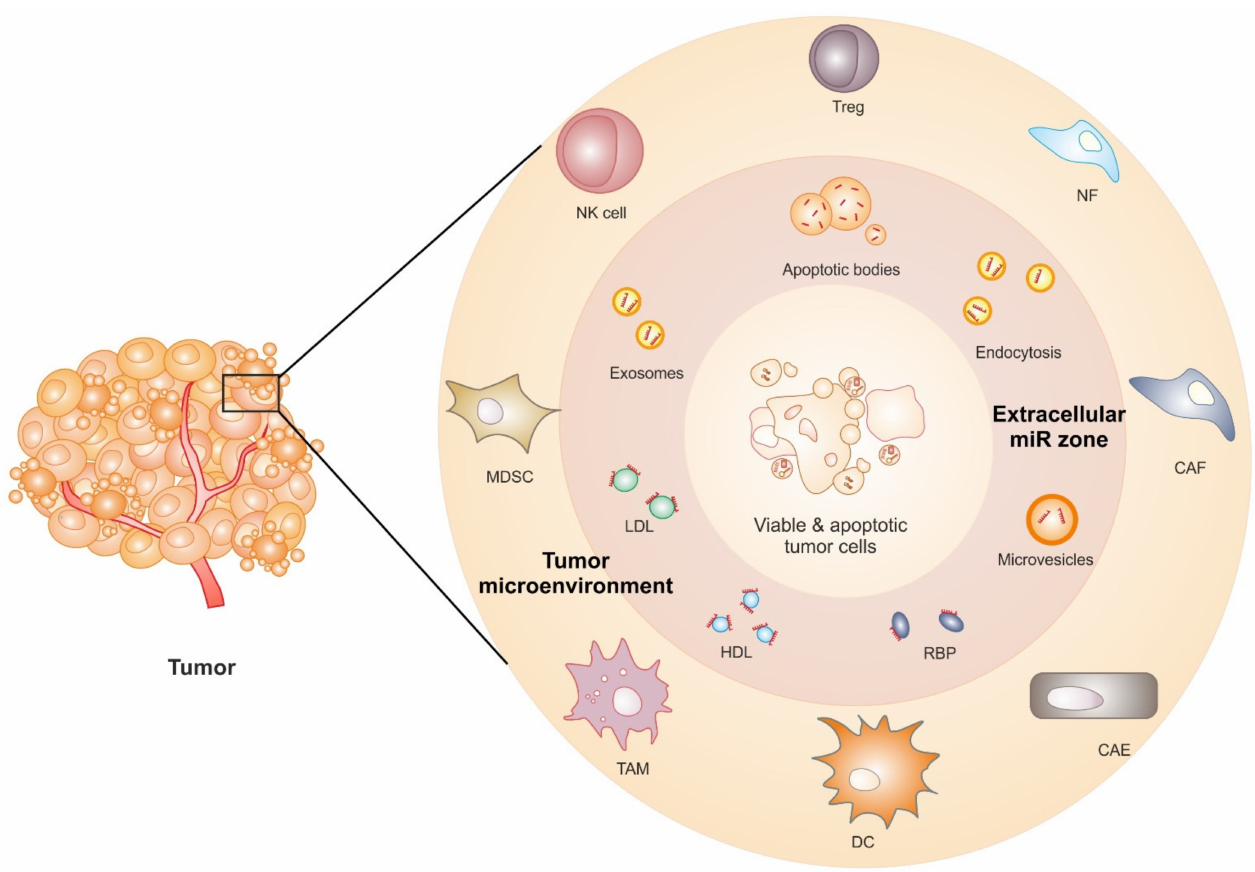
Figure 1. Extracellular miRs in the tumor microenvironment. The tumor microenvironment consists of viable and apoptotic tumor cells, along with stroma cells such as tumor-associated macrophage (TAMs), dendric cells (DC), cancer-associated endothelial cells (CAE), cancer-associated fibroblast (CAF), normal fibroblast (NF), regulatory T cells (Treg), natural killer (NK) cells, myeloid-derived suppressor cells (MDSC), etc. These cells crosstalk with extracellular miRs from the ‘extracellular miR zone’ in various forms and compositions, such as apoptotic bodies, endocytosis, and micro-vesicles, bound with RNA binding proteins (RBP), high-density lipoprotein (HDL), low-density lipoprotein (LDL), or